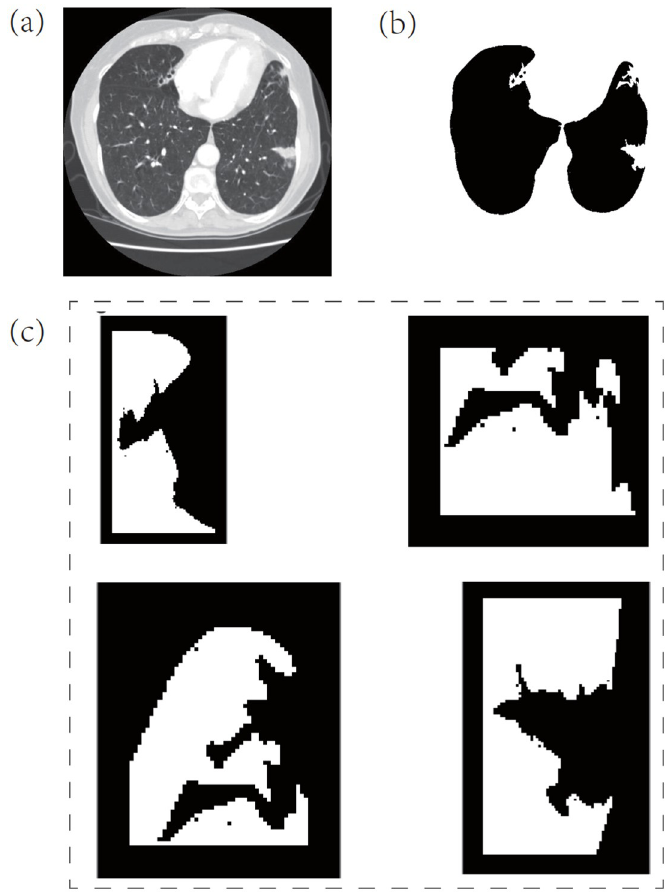
Fig 7. The detected blocks. (a) The original CT slice; (b) the initial lung region extracted by the algorithm; (c) the local blocks detected by the algorithm that needs boundary